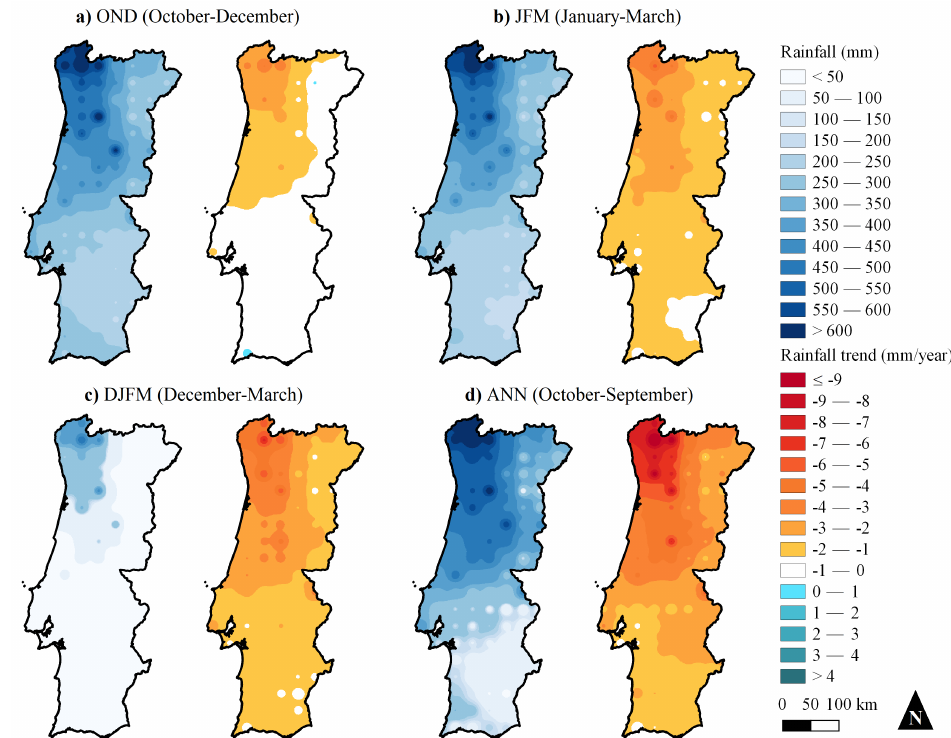
Figure 2. Average rainfall and Sen’s slope estimates (right and left side of each combo, respectively) for Portugal, based on the grid-point rainfall, for the 100 hydrological year period from 1919–2019 (IDW2 interpolation method used for